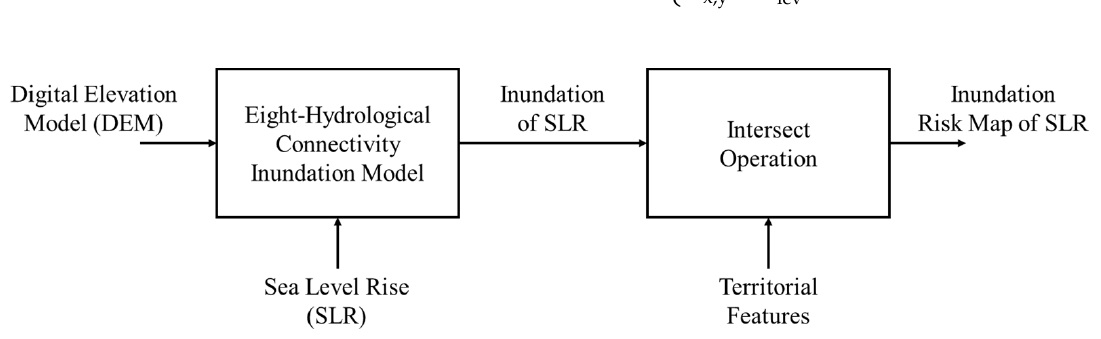
Figure 3. The Model Builder of ArcGIS to analyze SLR projections of 1 m, 2 m, and 3 m.